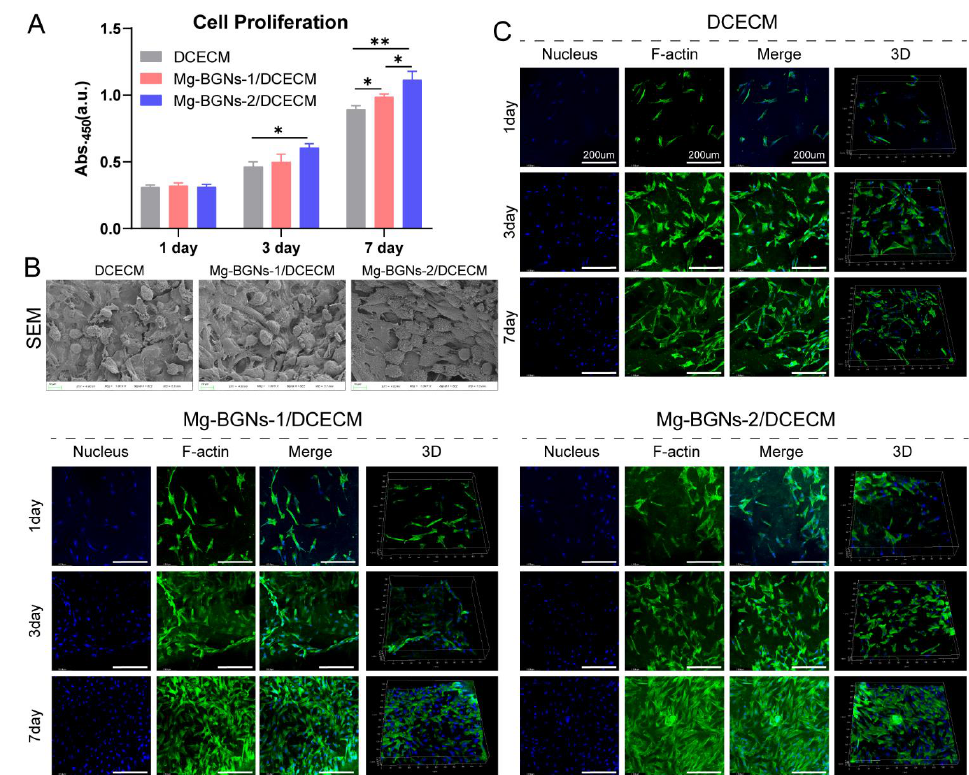
Figure 6. The cell proliferation, morphology and cytoskeletal architecture assessment of cells seeded on DCECM, Mg-BGNs-1/DCECM and Mg-BGNs-2/DCECM scaffolds: ( A ) The BMSCs proliferation analysis, which were seeded on DCECM, Mg-BGNs-1/DCECM and Mg-BGNs-2/DCECM scaffolds for 1, 3, and 7 days respectively; ( B ) The SEM images of BMSCs seeded on DCECM, Mg-BGNs-1/DCECM and Mg-BGNs-2/DCECM scaffolds for 3 days; ( C ) Confocal micrographs of the cytoskeletal architecture of BMSCs seeded on DCECM, Mg-BGNs-1/DCECM and Mg-BGNs-2/DCECM scaffolds for 1, 3, and 7 days. Data are expressed as mean ± standard deviation, * p < 0.05, ** p < 0.01.